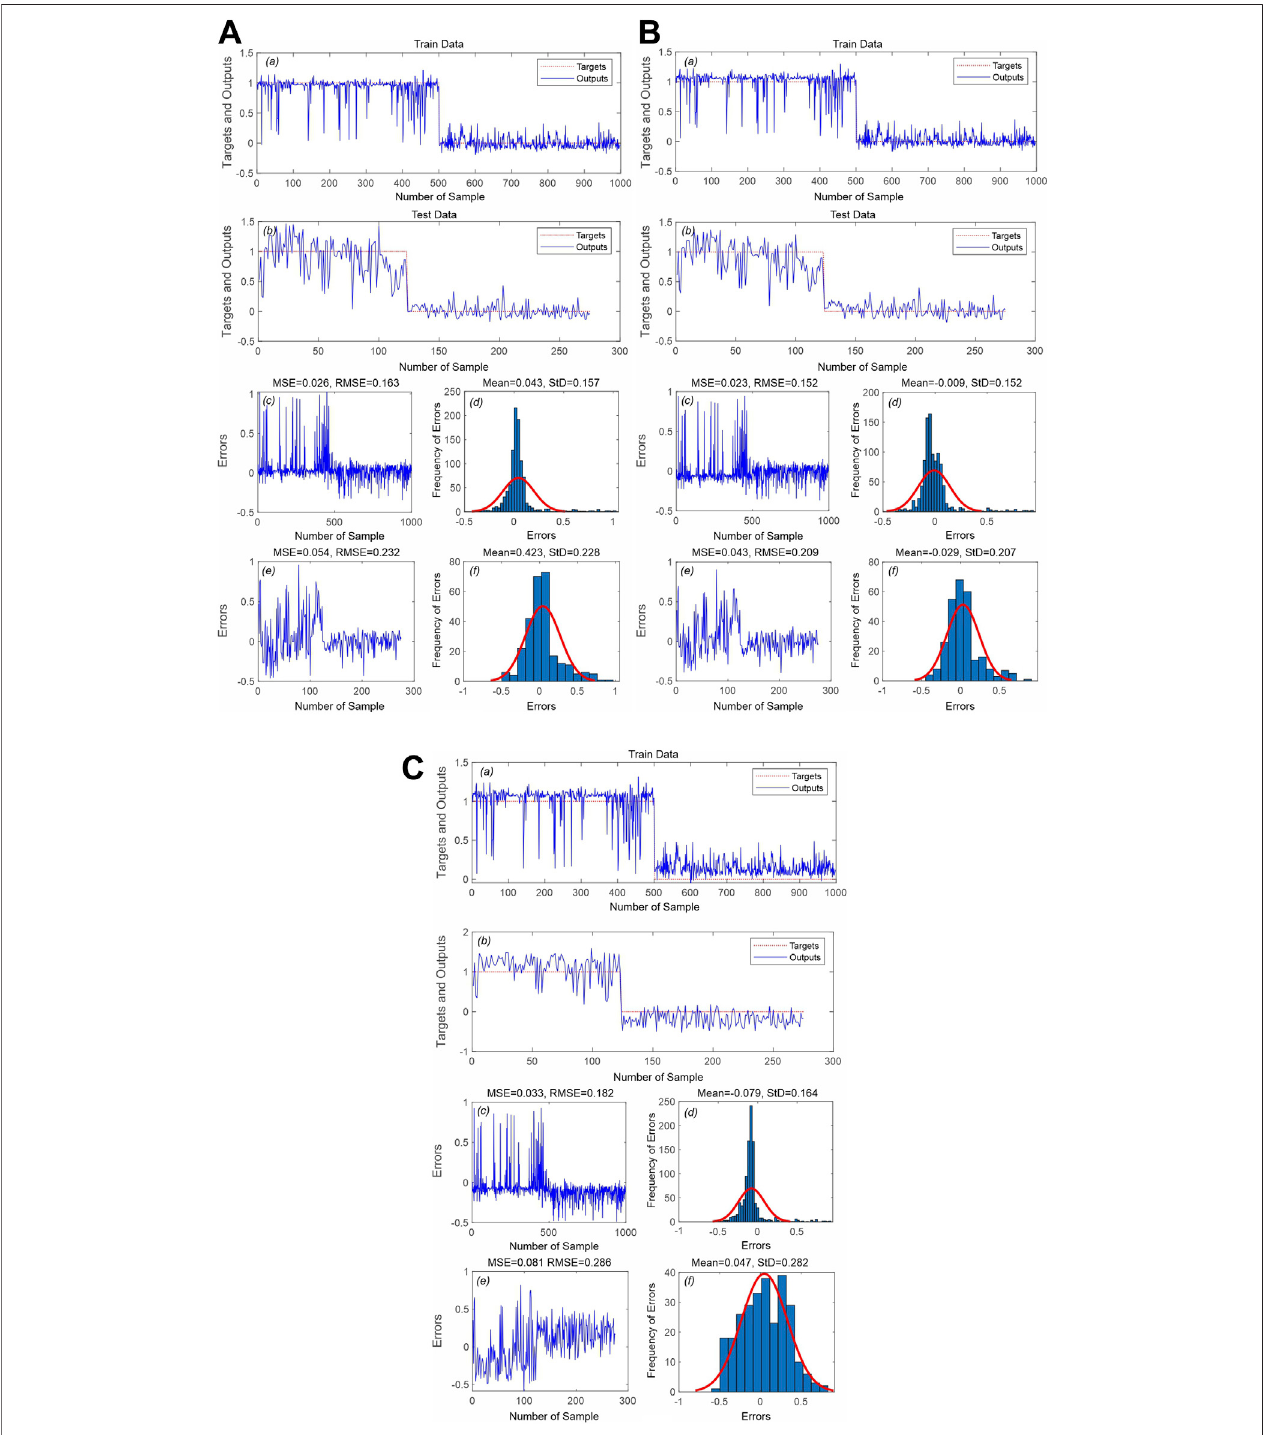
FIGURE 8 | Assessment of model performance: (A) LSTM, (B) ELM, and (C) RVFL. (a) Targets and outputs for the training dataset; (b) targets and outputs for the testingdataset;(c)MSEandRMSEforthetrainingdataset;(d)frequencyoferrorsforthetrainingdataset;(e)MSEandRMSEforthetestingdataset;(f)frequencyoferrors for the testing